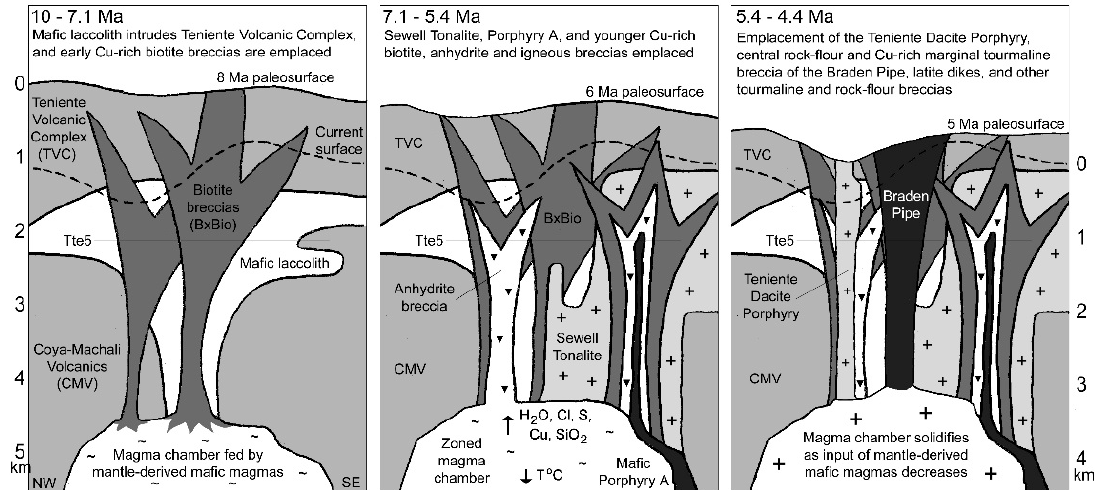
Figure 10. Model for the multistage development of the El Teniente deposit [23,33,34,39]. The main features of the model include (1) a large, long-lived ( ≥ 3 Myr) open-system magma chamber, crystallizing at ≥ 4 km depth, fed from below by mantle-derived mafic magmas and exsolving mineral-rich high-temperature magmatic fluids through its roof to produce the large breccia pipes that are prominent features this deposit; (2) decreasing magma supply in the Late Miocene and Pliocene as subduction angle decreases, leading to crystallization and solidification of this chamber; (3) progressive uplift and erosion that enhances this crystallization and solidification process and results in telescoping of di ff erent types of breccia and igneous rocks [12,13]; (4) progressive igneous di ff erentiation of the magma chamber associated with crystallization and volatile loss, generating felsic porphyries that intrude previously mineralized rocks above the chamber. No coeval volcanism is known to have occurred during mineralization, but once the chamber solidified, post-mineralization mantle-derived olivine lamprophyre dikes were emplaced. (Reprinted from Journal of Petrography, volume 52, Stern, C.R. et al., Magmatic evolution of the giant El Teniente Cu-Mo deposit, central Chile, page 1607, Copyright 2011, with permission from Oxford University Press.).